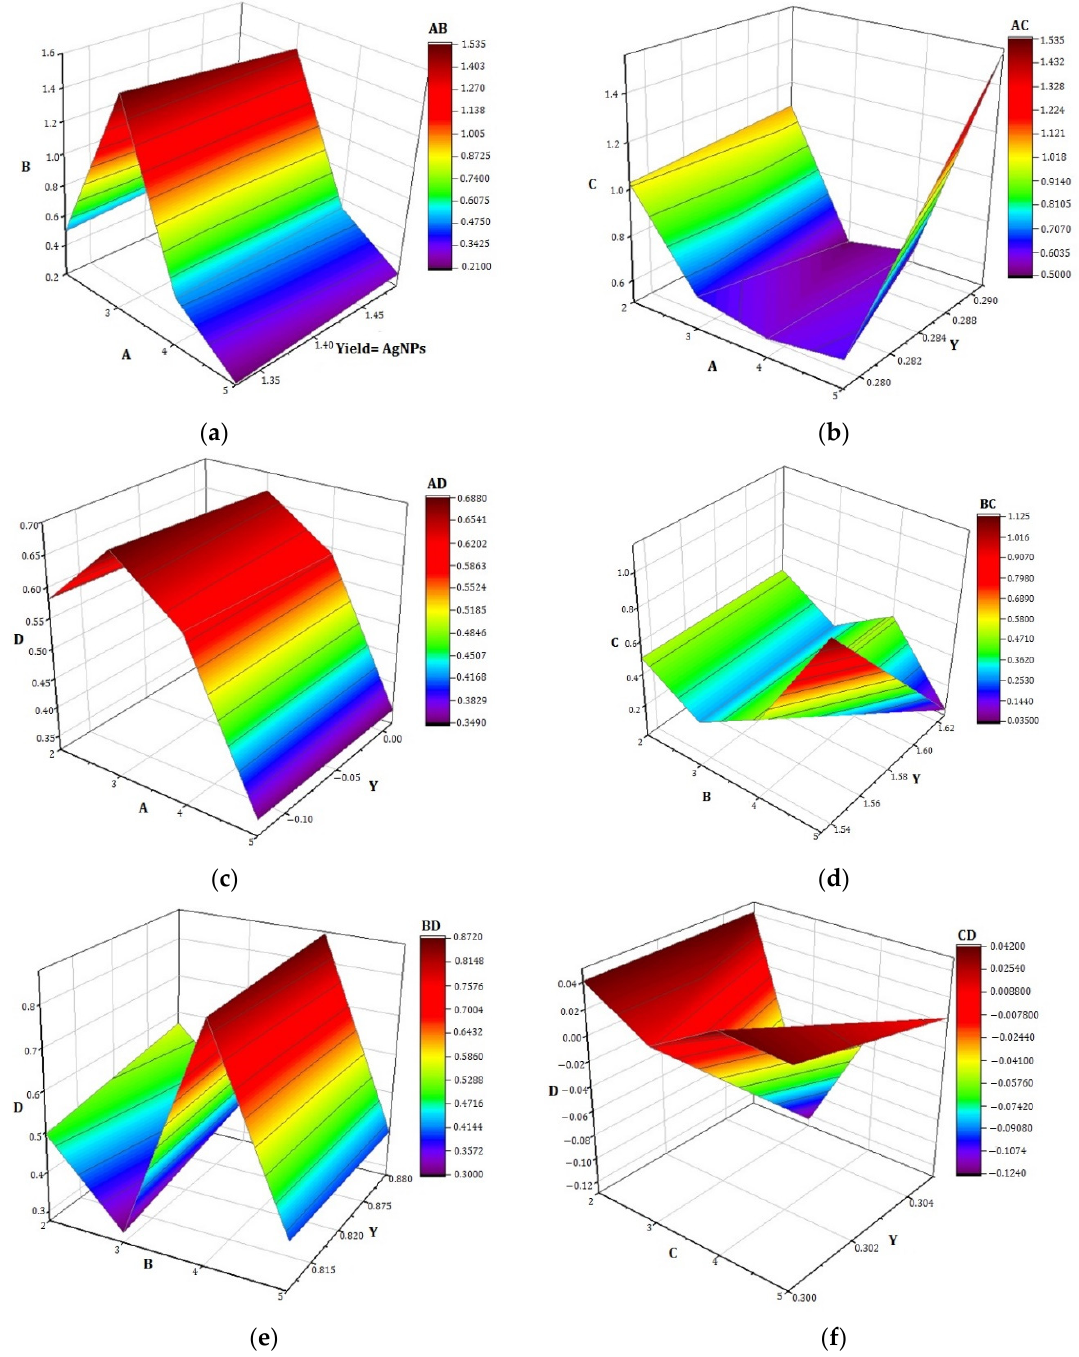
Figure 4. RSM surface plots ( a – f ) of the synthesized AgNPs revealing the effect of independent variables and their combination: AB, AC, AD, BC, BD, CD.